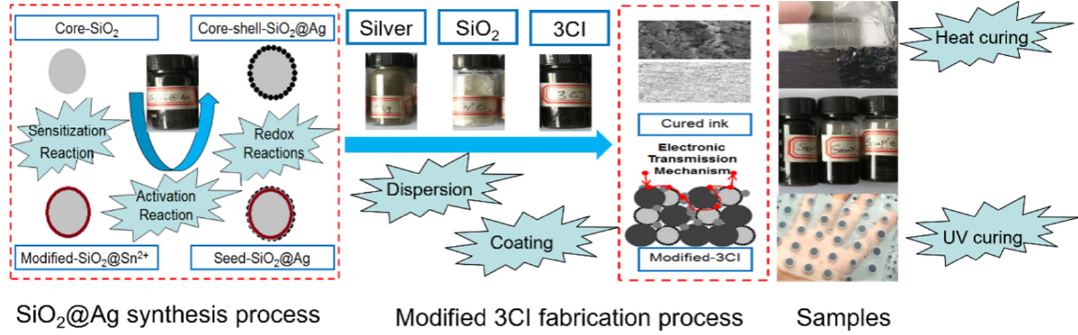
Figure 1. Modified 3CI fabrication process.